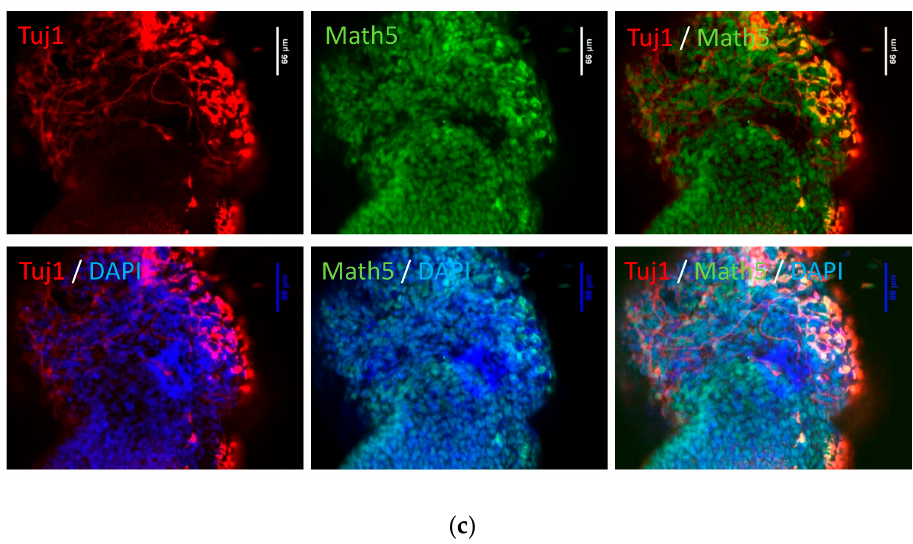
Figure 1. Induction of induced pluripotent stem cell (iPSC)-derived retinal ganglion cells (RGCs) in optic vesicles (OVs). ( a ) The schematic diagram of the protocol of RGC differentiation from human iPSCs (hiPSCs); ( b ) expression of positive RGC markers Tuj1 and Math5 as demonstrated by immunofluorescent microscopy using a magnification of 60× to observe the differentiation of the optic nerve in the OV; ( c ) with 25× the magnification, the whole differentiation can be observed.